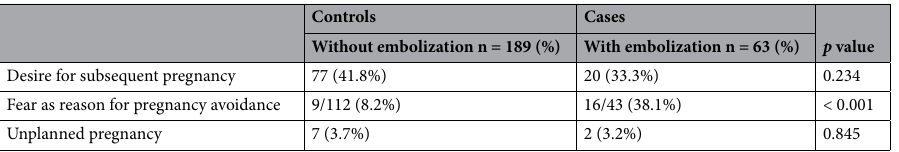
Table 4. Desire for and fear of subsequent